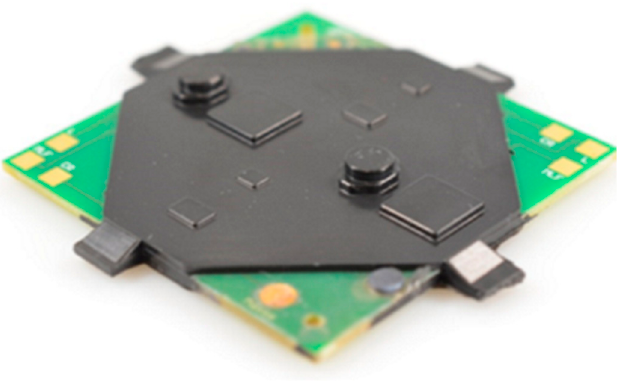
Figure 1. Example of encapsulated board-level packages as an outcome of earlier mold trials